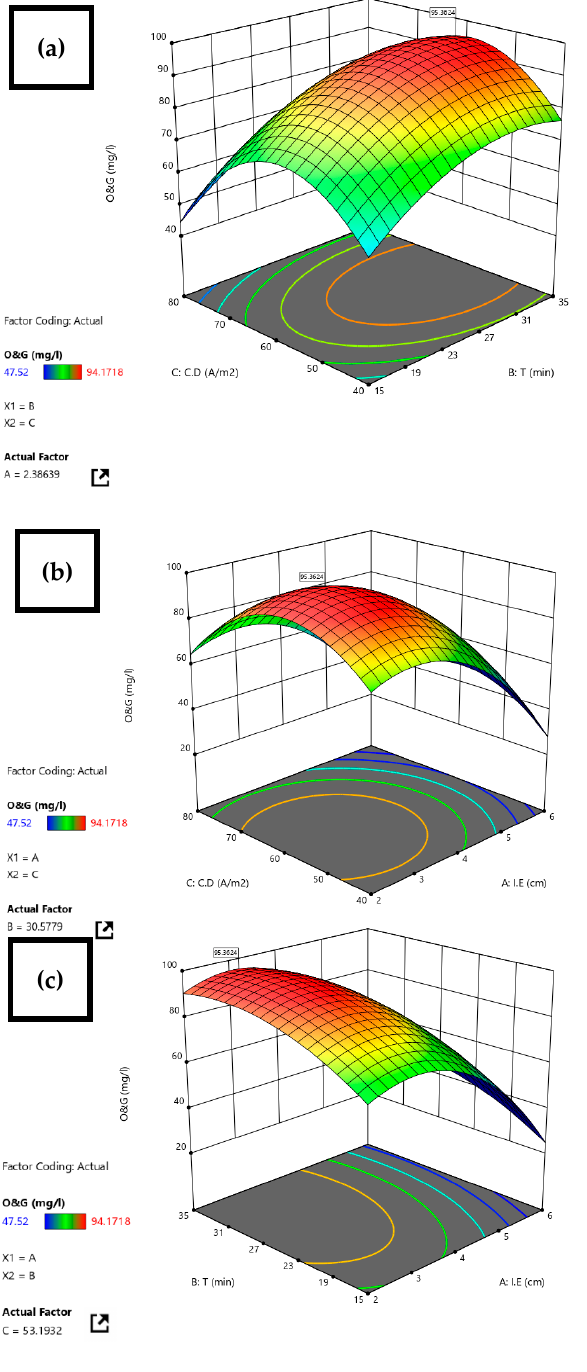
O&G and COD removal: ( a ) interaction effect of CD vs. T on O&G removal (%), ( b ) interaction of CD vs. ID on O&G removal (%), ( c ) interaction effect of T vs. ID on O&G removal (%), ( d ) inter-